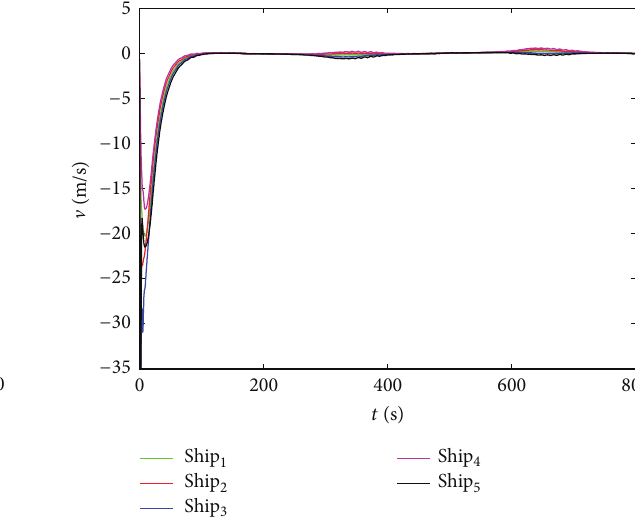
Figure 5: The sway velocity curve of each vessel.